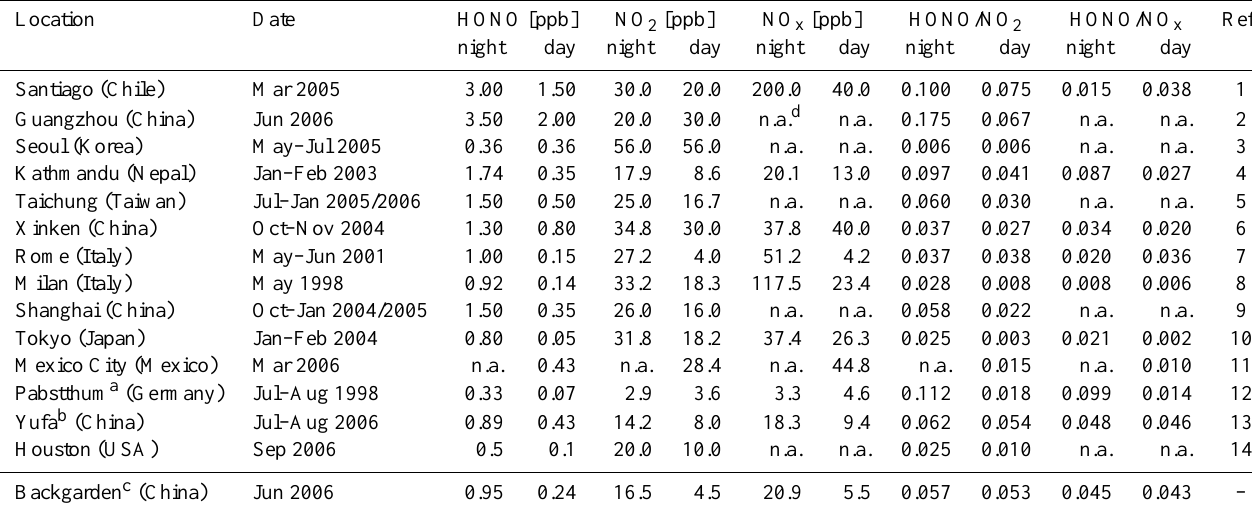
Table 2. Overview on HONO measurements performed in or in the vicinity of big cities. The daytime values correspond to ± 3h around local noon, the nighttime values reperesent averages between sunset and sunrise.